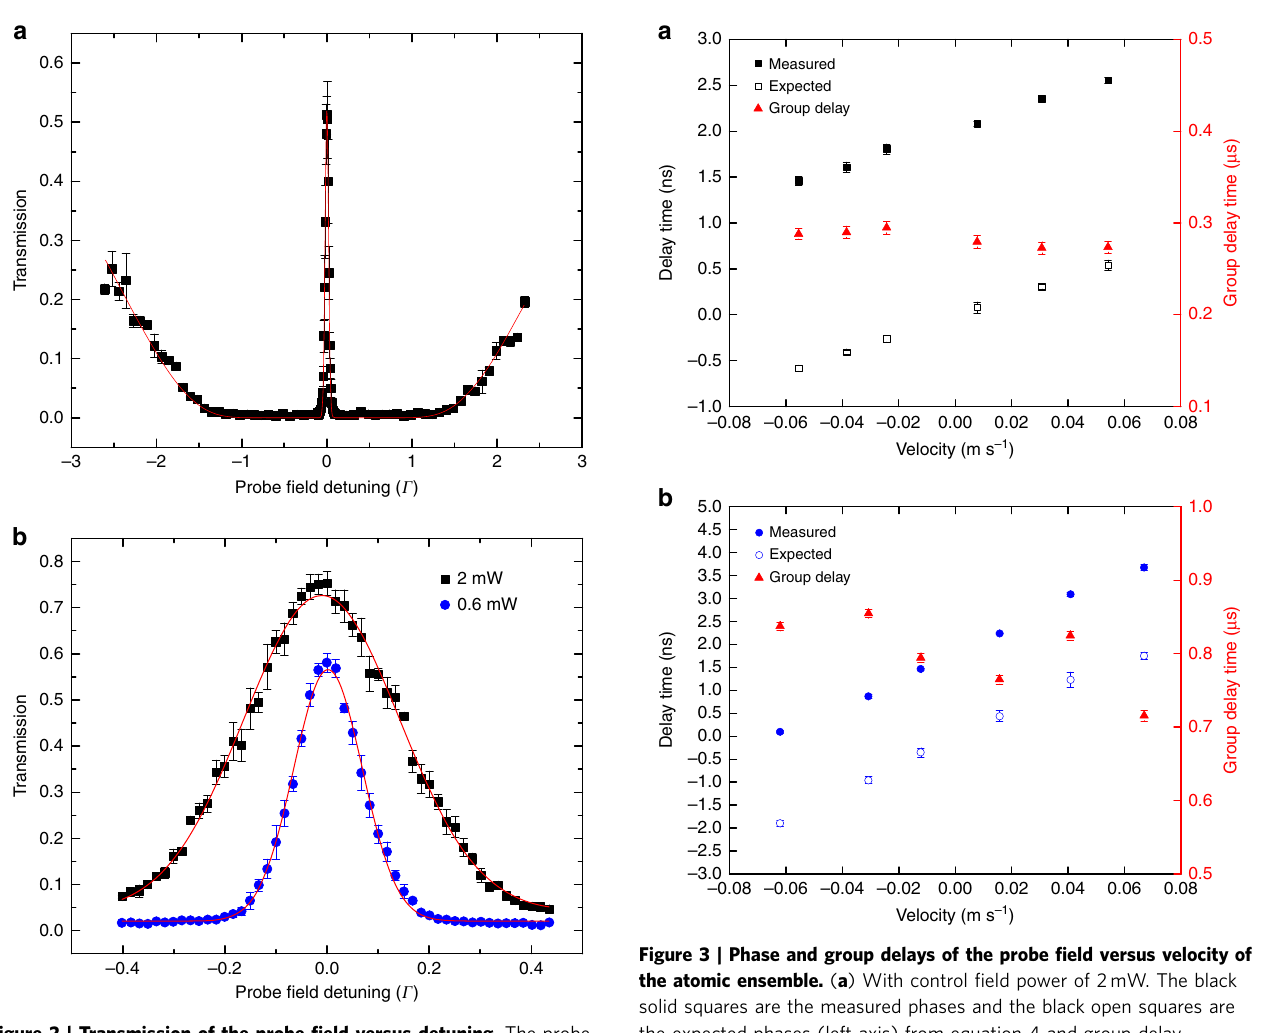
Figure 2 | Transmission of the probe field versus detuning. The probe field is on 5 2 S 1/2 , F ¼ 2 to 5 2 P 3/2 , F 0 ¼ 3 transition and the control field is on 5 2 S 1/2 , F ¼ 3 to 5 2 P 3/2 , F 0 ¼ 3 transition. The probe field detuning is expressed in terms of excited state spontaneous decay rate G . The standard error of each data point is calculated from the average of three experimental trials. ( a ) Electromagnetically induced transparency spectrum for optical depth ( OD ) measurement. The fitting curve shows OD ¼ 36.0(0.4) and control field Rabi frequency O c ¼ 0.582(5) G . The duration of the probe field is 100 m S and the control field is turned on 100 m S before the probe field is on in order to prepare the state of atoms in the 5 2 S 1/2 , F ¼ 2. The standard error of the central peak is calculated from five data points while the rest are two data points. ( b ) Transmission peak of probe field with 2mW (black squares) and 0.6mW (blue circles) control field power. The fitted Gaussian functions of black squares an blue circles give 1/ e 2 width of 0.306(6) G and 0.134(1) G , respectively.